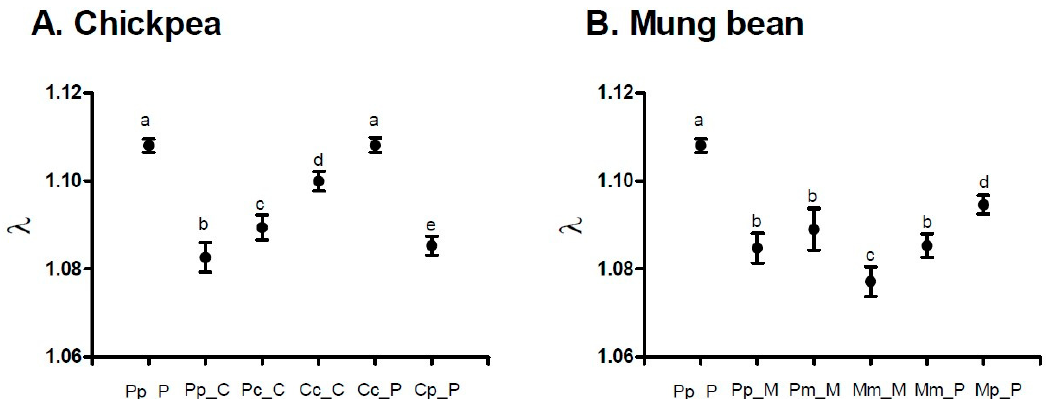
Figure 4. Jackknife estimates and confidence intervals of the finite rate of population increase ( λ ) for experimental groups during the host-shift process to: ( A ) chickpea and ( B ) mung bean seeds. Different letters indicate statistically significant differences between groups at p < 0.005, Student t -tests. Table 1. Mixed model ANOVA. Selection regime (S), rearing host (R) and offered host (O) represent the fixed factors, while populations nested within S × R interaction is the random factor. Shown are F values and statistical significance for: ( A ) Preadult life history traits (egg-to-adult viability, developmental time and body mass) and ( B ) adult life history traits (life span, early and total fecundity).